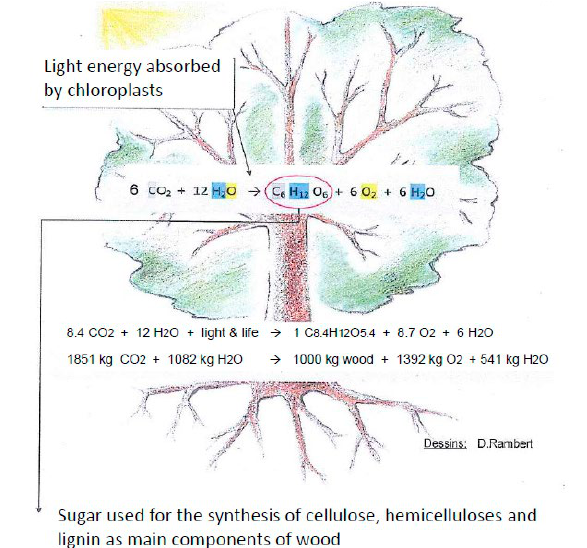
Figure 1. Complete general equation of photosynthesis, with an indication of the destination of components (above) and average proportions accepted for wood, with indication of weight ratios compared to the dry matter of wood, according to Zimmer and Wegener (1996) (below) [drawing D.